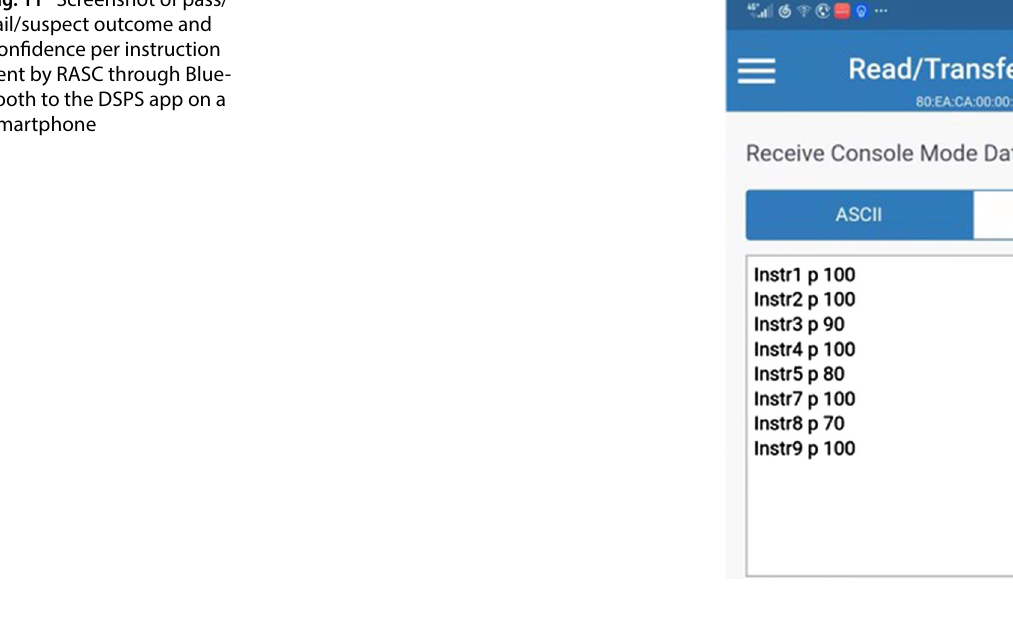
Fig. 11 Screenshot of pass/ fail/suspect outcome and confidence per instruction sent by RASC through Blue-